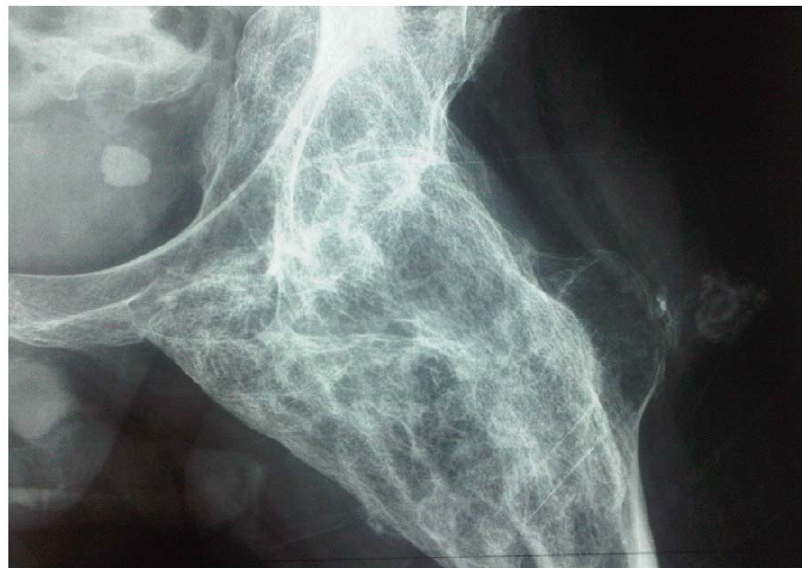
Figure 2. Encircling Hip Heterotopic Ossification.